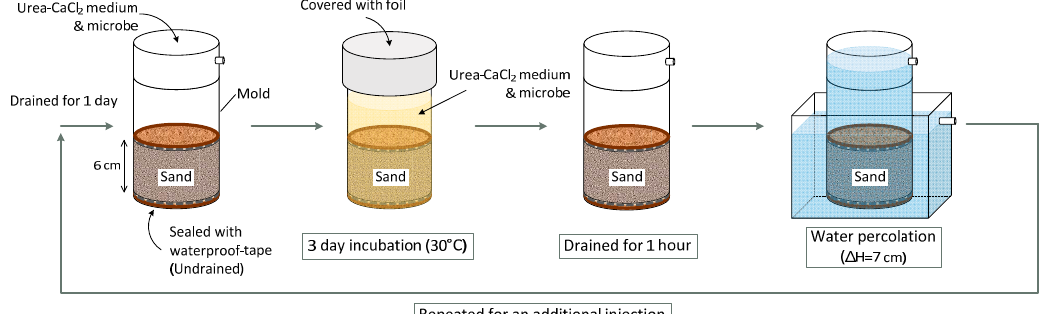
Figure 2. Calcite precipitation process.